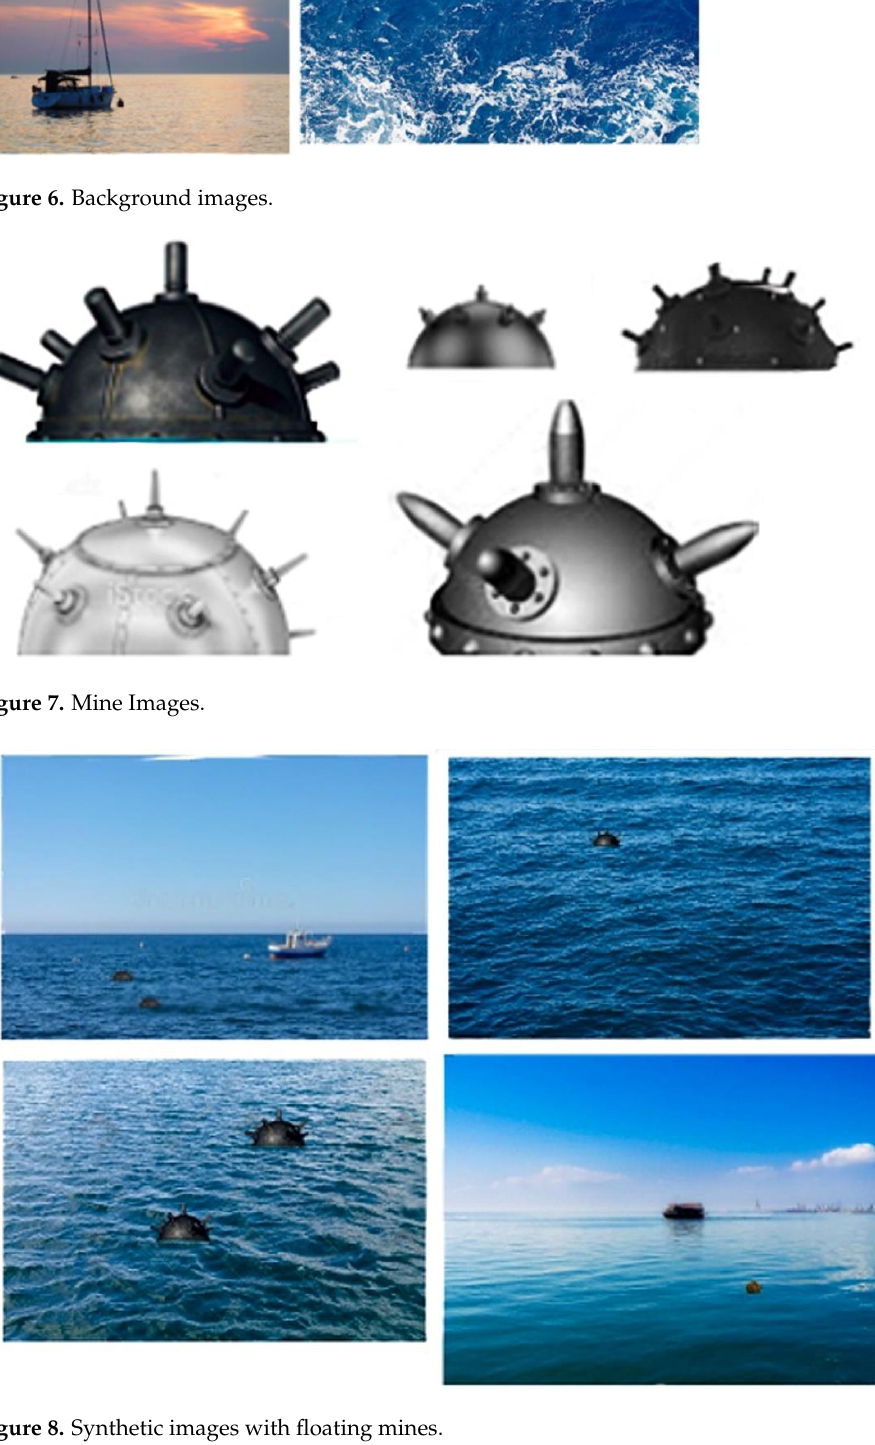
Figure 6. Background images.